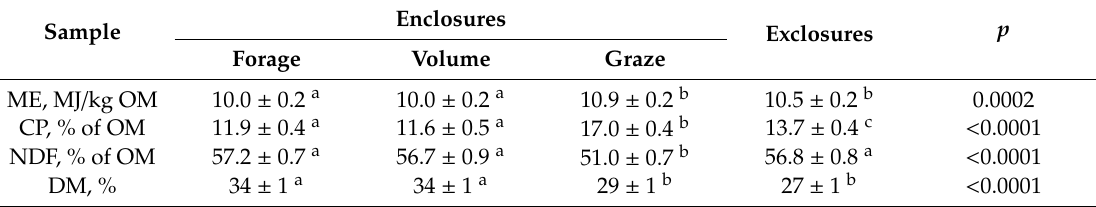
Table 2. Content of dry matter (DM), metabolizable energy (ME) per kg organic matter (OM), crude protein (CP) as % of OM, and neutral detergent fiber (NDF) as % of OM in three di ff erent types of pasture samples collected in three enclosures grazed by horses, and in three exclosures per enclosure, monthly